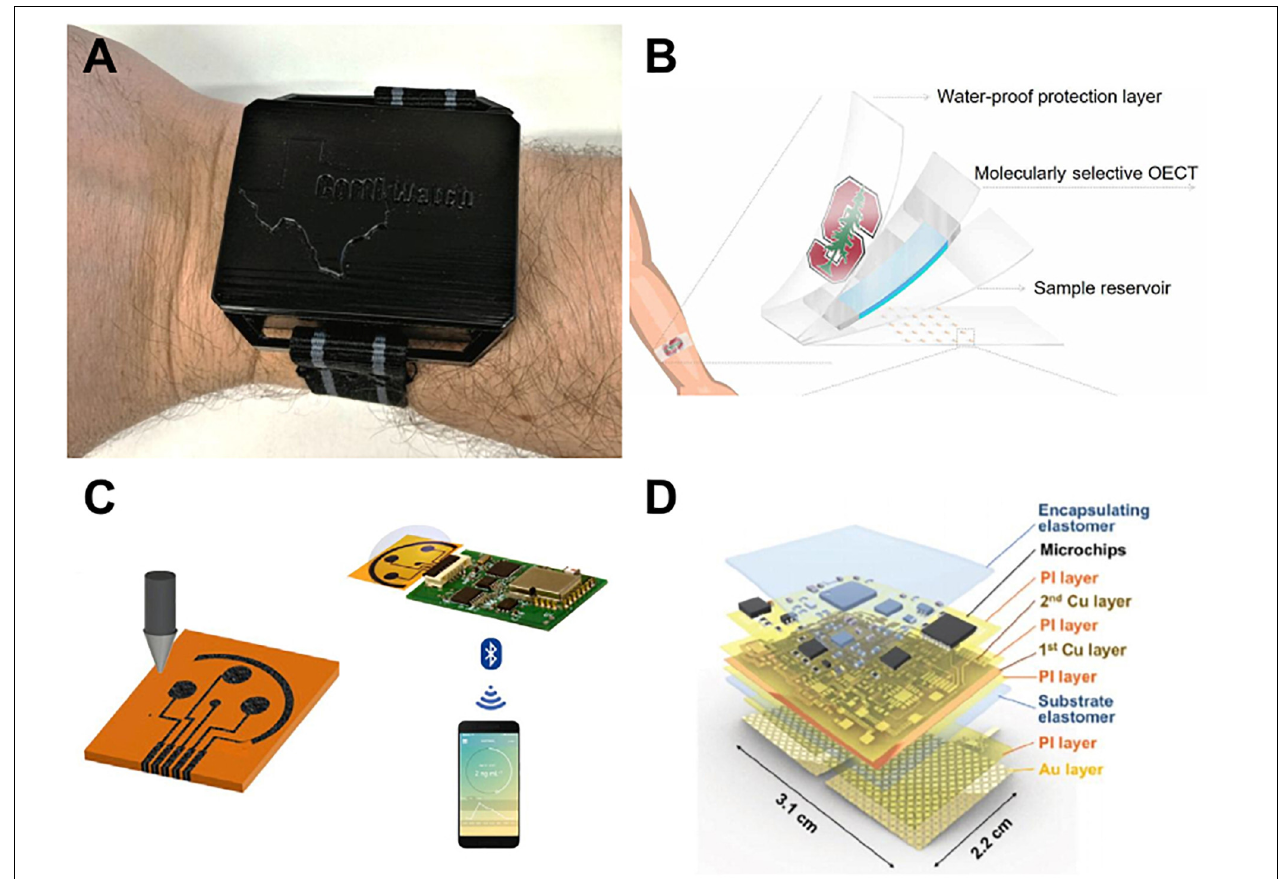
FIGURE 2 | Recent sweat stress sensor designs. (A) Wearable CortiWatch (Rice et al., 2019) reprinted via Creative Commons Attribution 4.0, (B) MIP sensor on flexible SEBS substrate (Parlak et al., 2018) reprinted via Creative Commons Attribution 4.0. (C) printed graphene-based wireless cortisol sensor, reprinted with permission from Torrente-Rodríguez et al., copyright 2020 by Elsevier (Torrente-Rodríguez et al., 2020). (D) galvanic skin response sensor SKINTRONICS (Kim et al., 2020) reprinted via Creative Commons Attribution